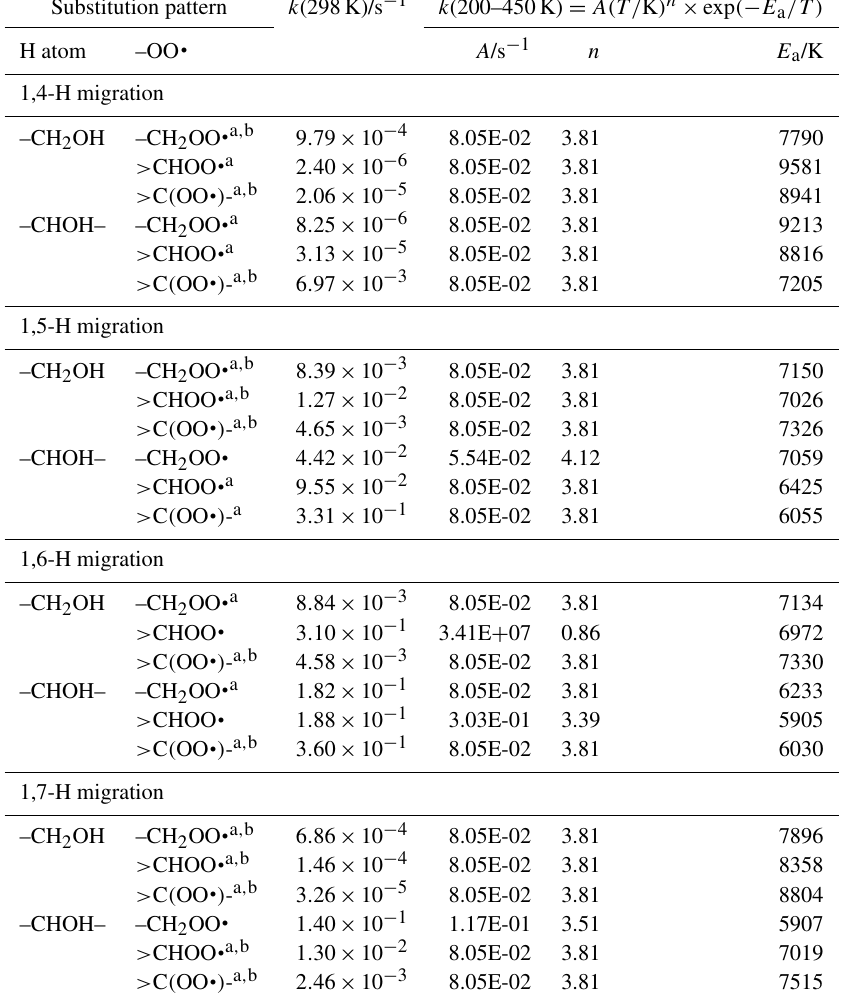
Table 6. Rate coefficients for α -OH-substituted H migration in peroxy radicals, accounting for all abstractable H atoms in the group. Substitution